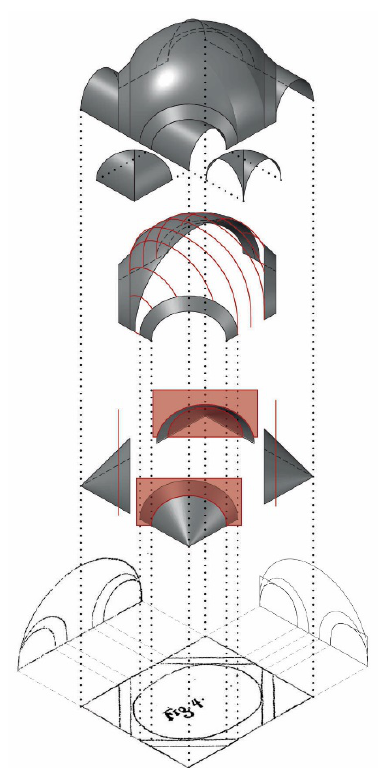
Figure 3. ‘A fasce’ vault in Plate XX of the Architettura Civile (Modelling: F. Natta)